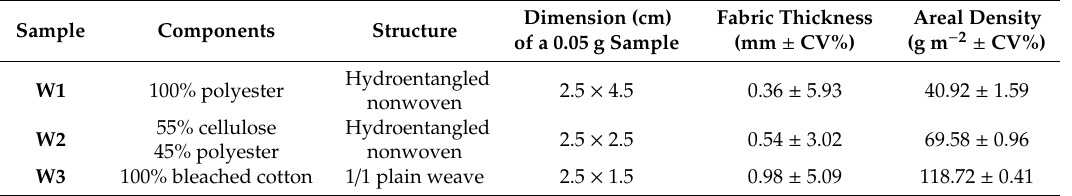
Table 1. Information of material, structure, dimension, fabric thickness and areal density. The data was reported as average of 10 / 5 repetitions including their coe ffi cients of variance in percentage